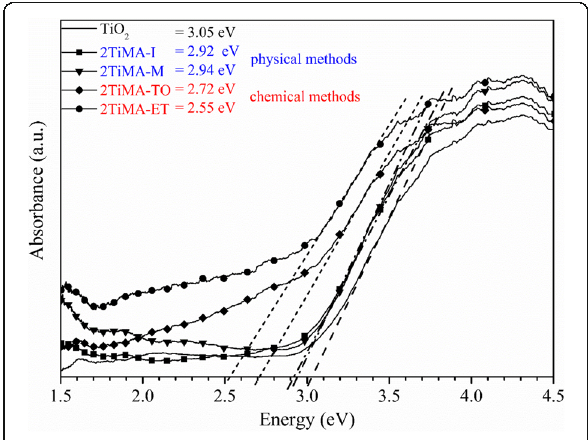
Fig. 9 DRS spectra and bandgap energy of the samples: pristine TiO 2 , 2TiMA-M, 2TiMA-I, 2TiMA-ET, and